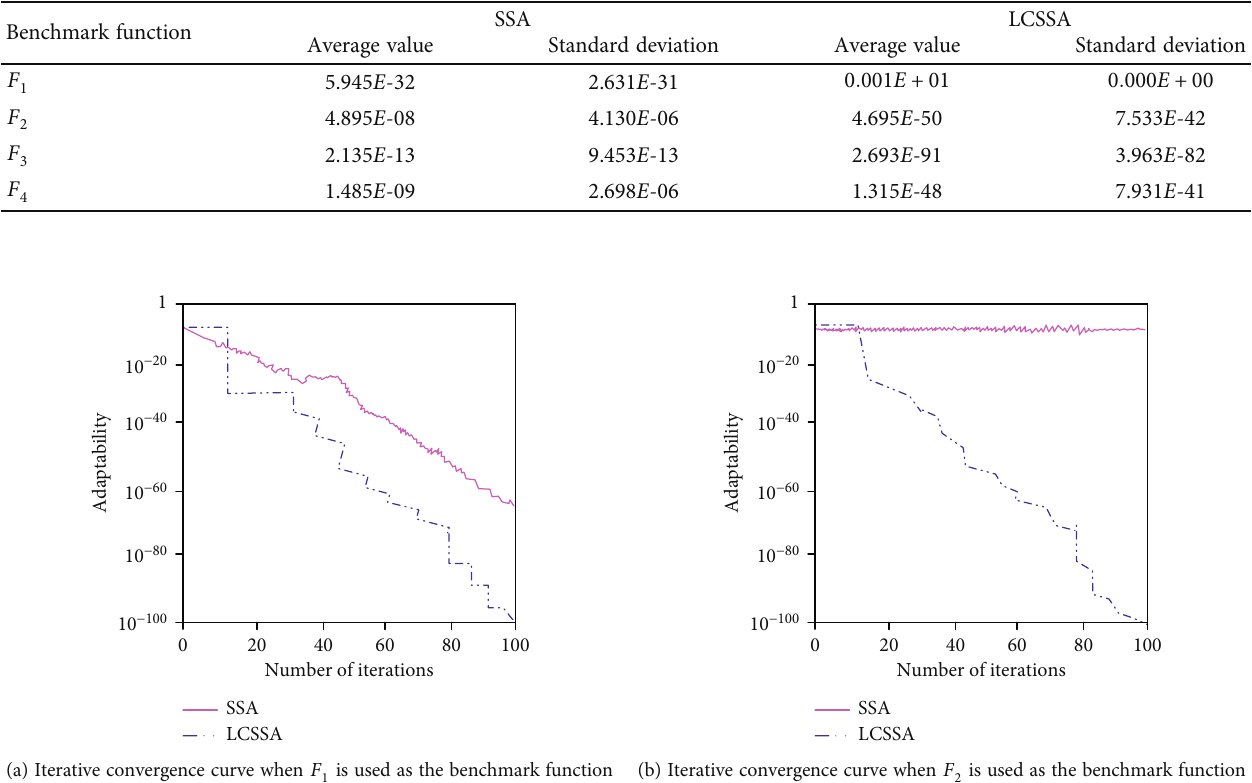
Table 3: Test results of SSA and LCSSA under 8 benchmark